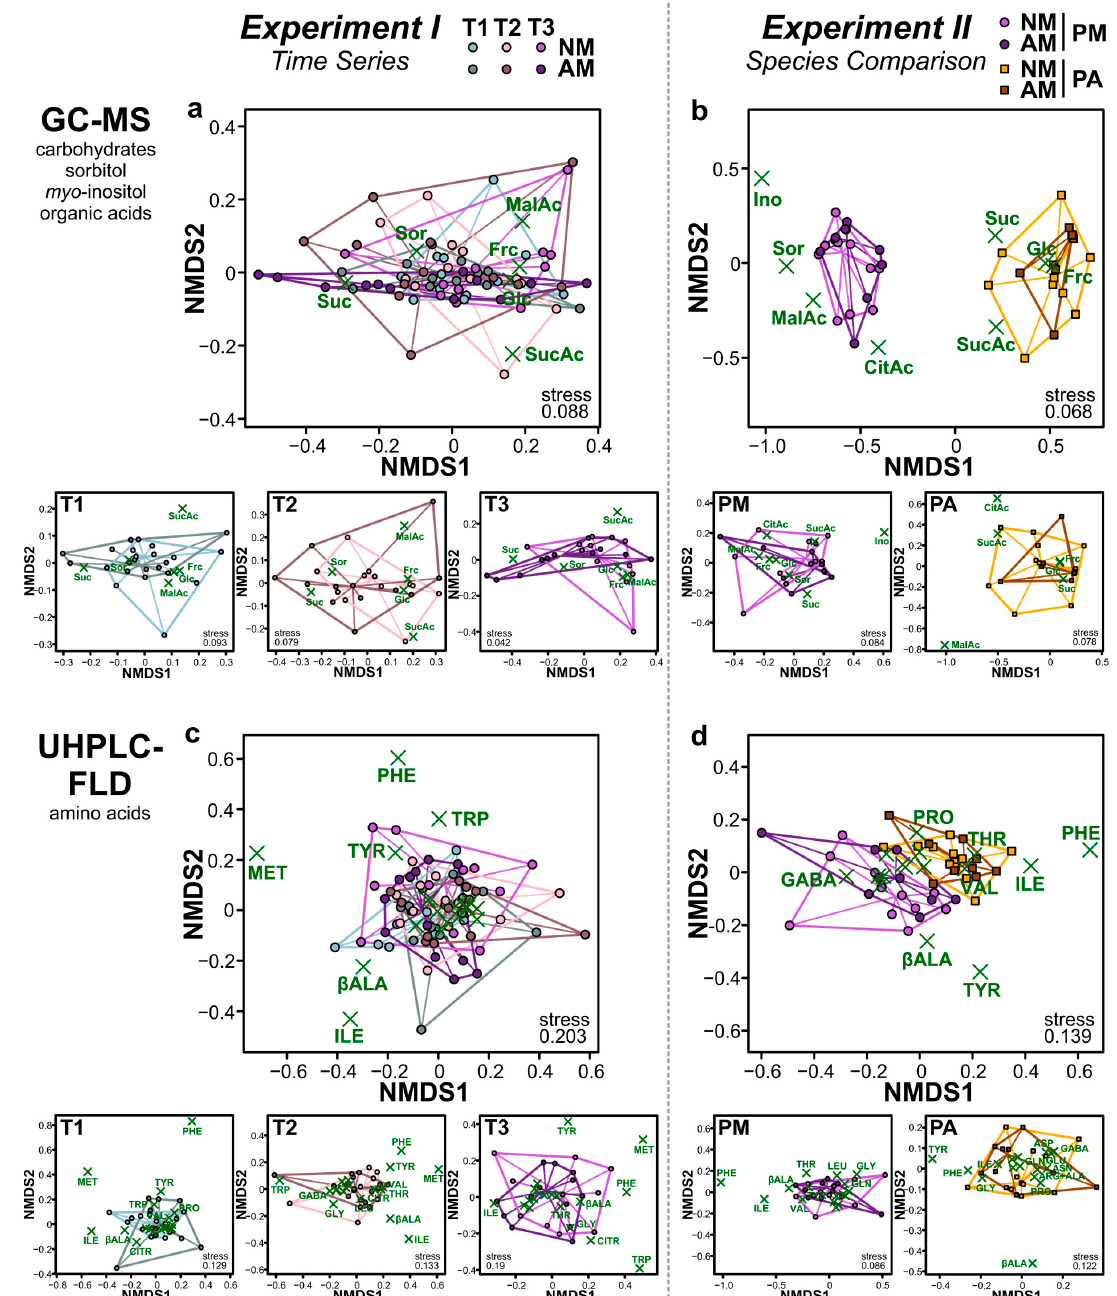
Figure 2. Non-metric multidimensional scaling (NMDS) plots showing the relative composition of primary metabolites (based on relative proportions) in phloem exudates of Plantago major (PM) and Poa annua (PA) plants that have been left as controls (NM) or were inoculated with the arbuscular mycorrhizal fungus Rhizoglomus irregulare (AM). Metabolites were measured per GC-MS (first row) and UHPLC-FLD (second row). ( a , c ) Experiment I ( Time Series ) with P. major , showing data at the time points T1, corresponding to 20 days post inoculation (dpi), T2 (30 dpi), and T3 (63 dpi), across all time points (top) and separately for each time point (bottom); ( b , d ) Experiment II ( Species Comparison ) with P. major and P. annua at 66–68 dpi, across both species (top) and separately for each species (bottom). Stress values of NMDS analyses are shown at the bottom. Different groups are surrounded by convex hulls, i.e., closed curves surrounding all data points, and all data points are connected to the corresponding medians of the treatment groups. Green crosses indicate loadings of the metabolites; in crowded regions of the plots, labels of metabolites with short loadings were partly omitted. Full names of the metabolites are given in Table 1. The sample sizes (biological replicates) were: n = 11–12 ( Experiment I ), n = 9–12 ( Experiment II